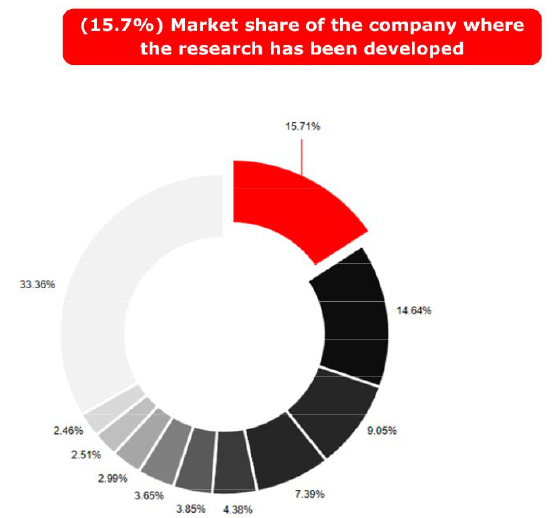
Figure 1. Market share 2019 (Company of study, 2019)